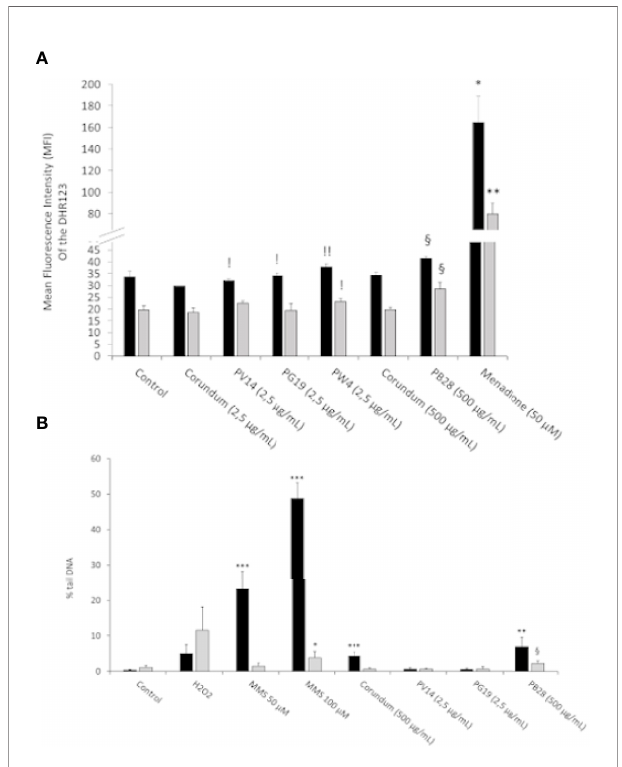
FIGURE 6 | ROS and Genotoxicity assessment. Panel (A) - Measurement of intracellular ROS with DHR123 (500ng/mL). Menadione is used as positive control. Panel (B) - DNA damage determined by a comet assay. The percentage of DNA in the comet tail is measured as an indicator of the extent of damage to DNA. Methyl methanesulfonate (MMS) and hydrogen peroxide are used as positive controls. Black bars: acute exposure (24 hours). Grey bars: exposure for 24 hours followed by a 3-day post-exposure recovery period. Signi fi cance of symbols: *: different from negative control only; §: different from both negative and corundum controls (500 µg/ml).!: different from corundum control only. Number of symbols: 1: p < 0.05; 2: p < 0.01; 3: p <